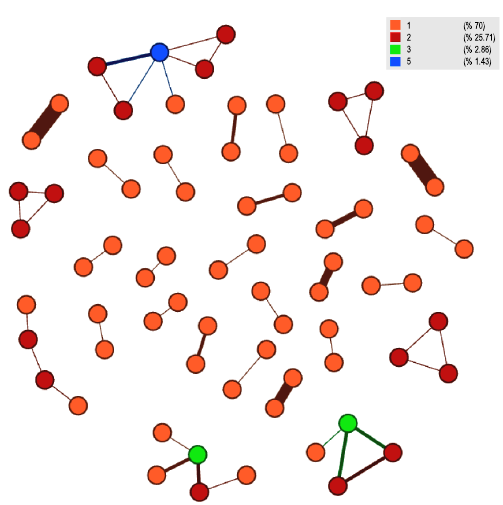
Fig. 7. Africa market